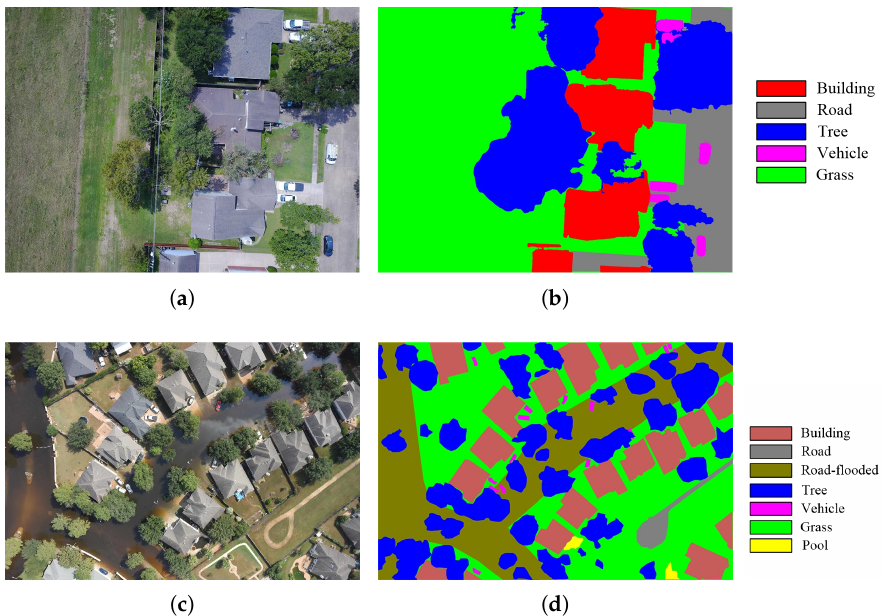
Figure 4. Images from FloodNet: ( a ) 6651 RGB; ( b ) 6651 ground truth; ( c ) 7577 RGB; ( d ) 7577 ground truth. Table 1. Numbers of ground-truth pixels for all categories in two selected images from FloodNet.